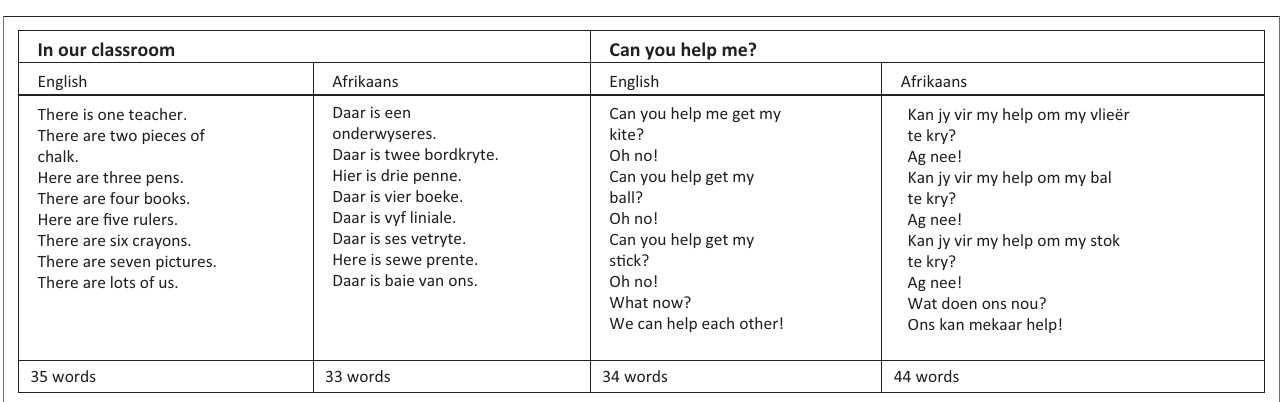
FIGURE 2: Intervention